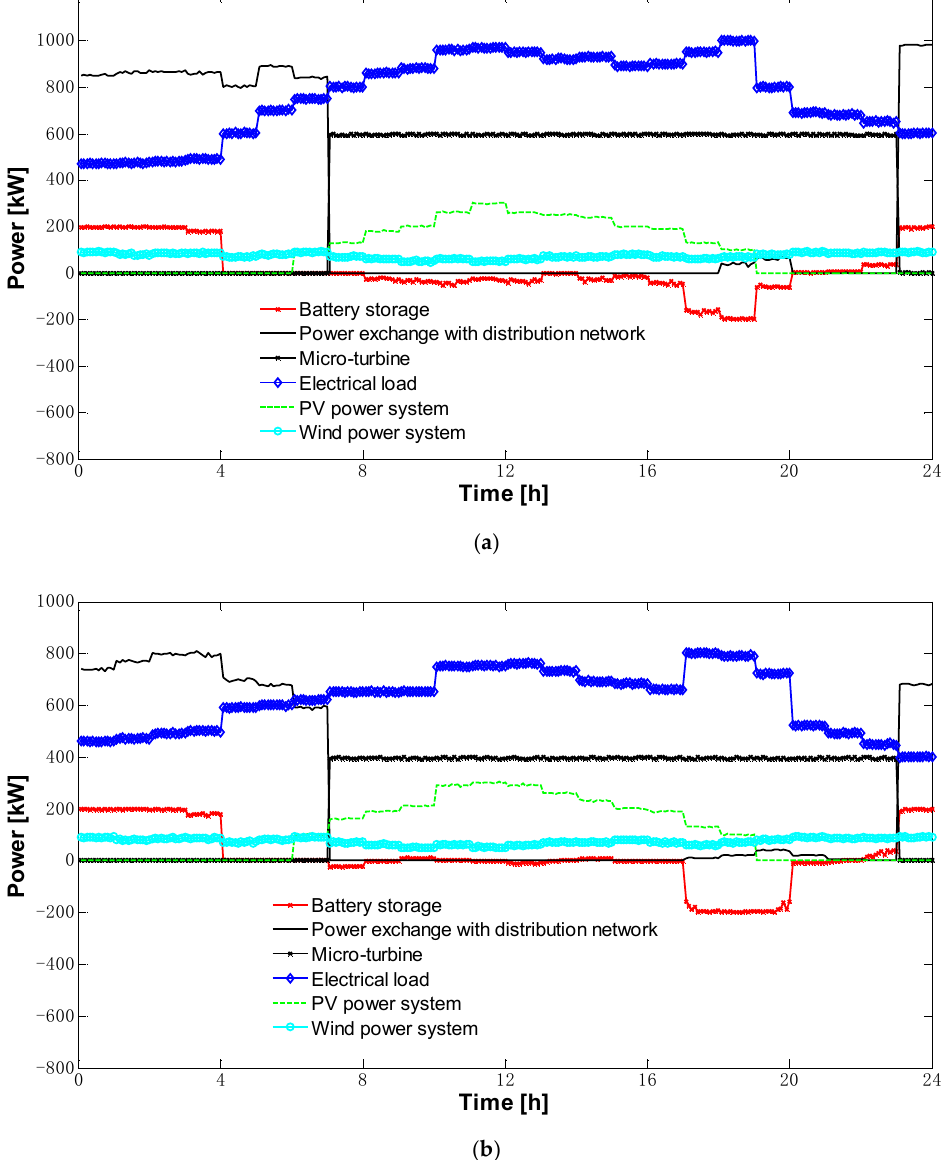
Figure 10. The electrical load balance curves of a typical day in winter ( a ) and summer ( b ) under real-time optimal dispatching mode.